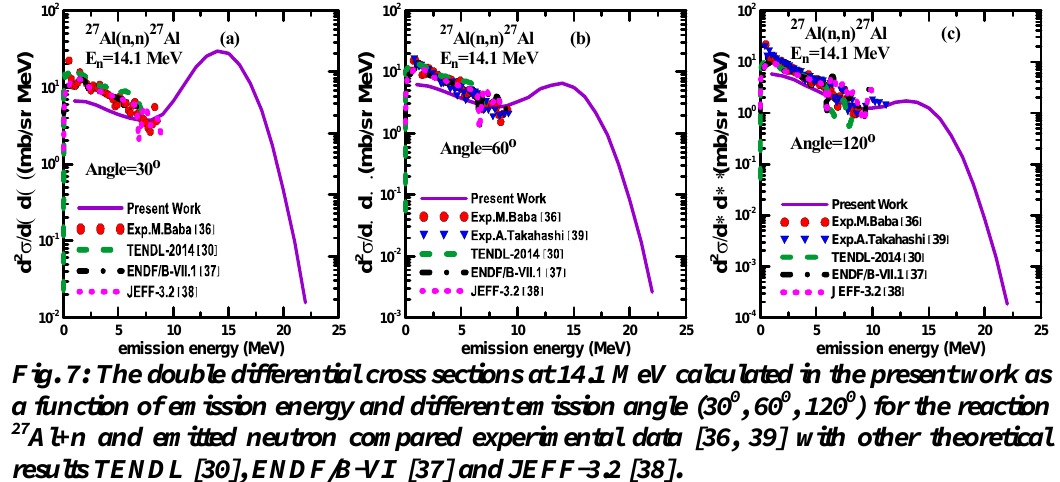
Fig. 7: The double differential cross sections at 14.1 MeV calculated in the present work as a function of emission energy and different emission angle (30 0 , 60 0 , 120 0 ) for the reaction 27 Al+n and emitted neutron compared experimental data [36, 39] with other theoretical results TENDL [30], ENDF/B-VI [37] and JEFF-3.2 [38].